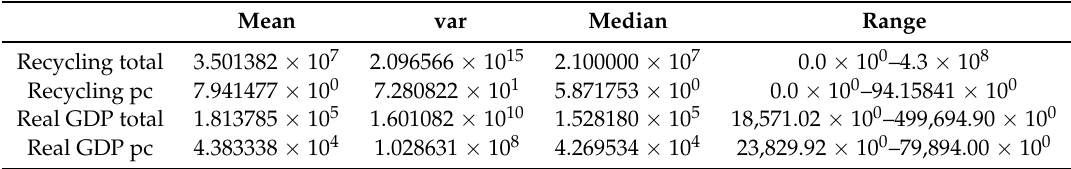
Table 1. Descriptive Statistics of the data for All States of